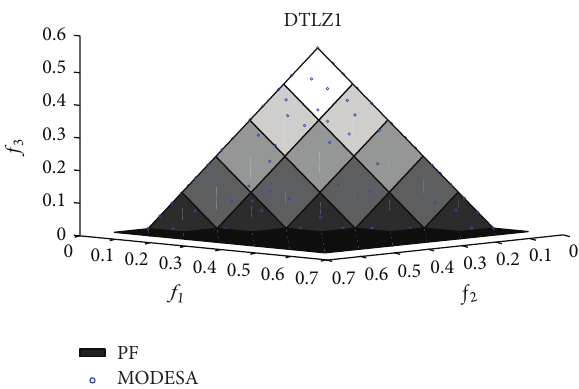
Figure 8: Plots of the nondominated solutions with the lowest IGD- metric values found by MODESA in 10 runs in the objective space on DTLZ1 where 𝑁 = 100 and 𝑇 = 250 .